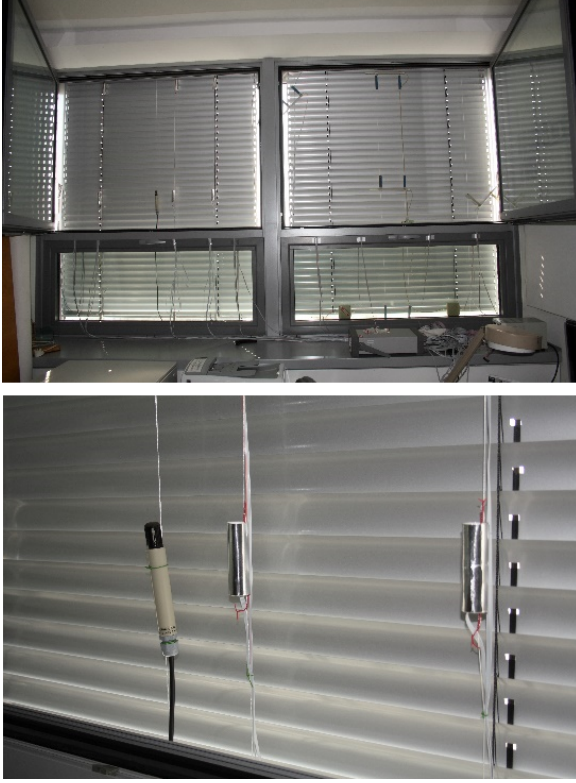
Figure 17: View of the installed sensors for measuring the physical parameters of the cavity of the double skin facade element.